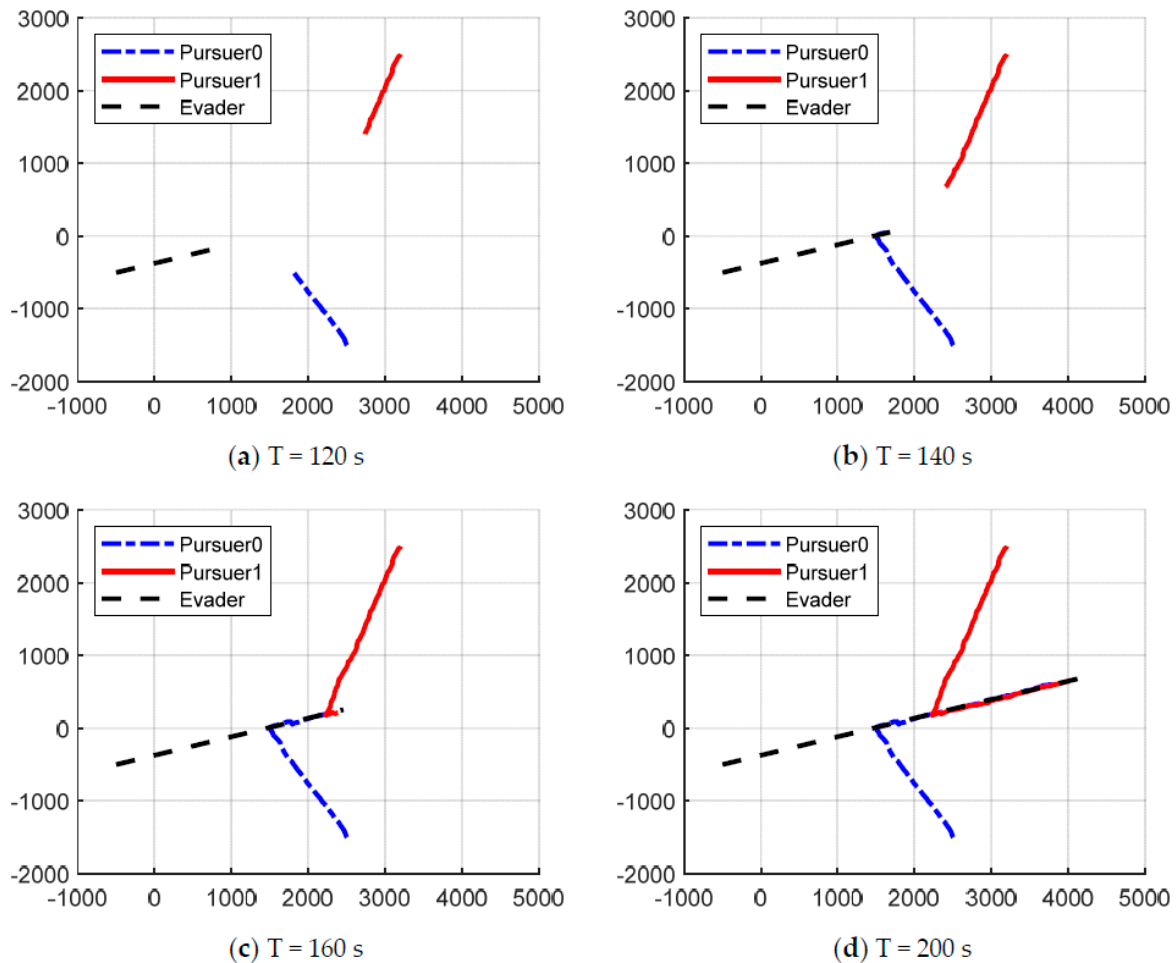
Figure 9. The traces of P 0 , P 1 and E 0 based on the Apollonius circle without velocity